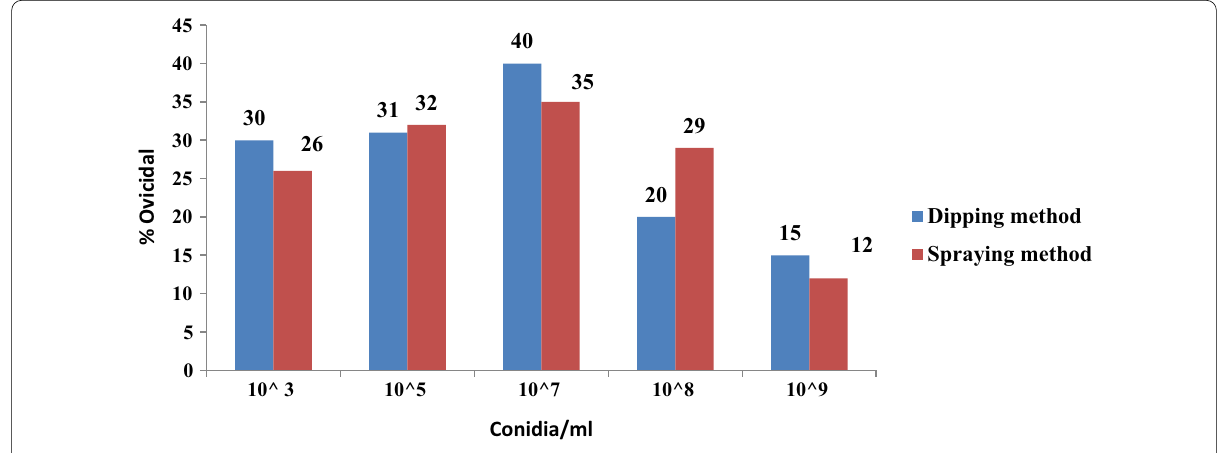
Fig. 8 Effect of conidial dilution of Isaria fumosorosea strain on Eublemma amabilis eggs by dipping and spraying method